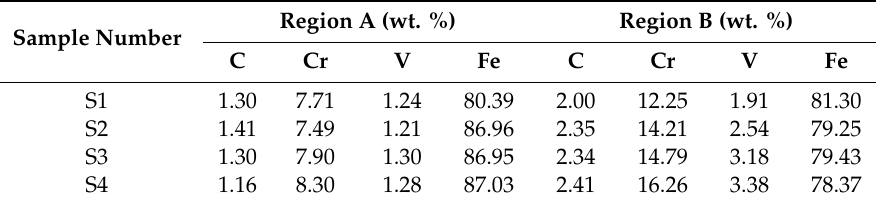
Table 4. Content of main alloy elements in regions A and B of wear-resistant Fe-based alloys on the outside of gradient materials.